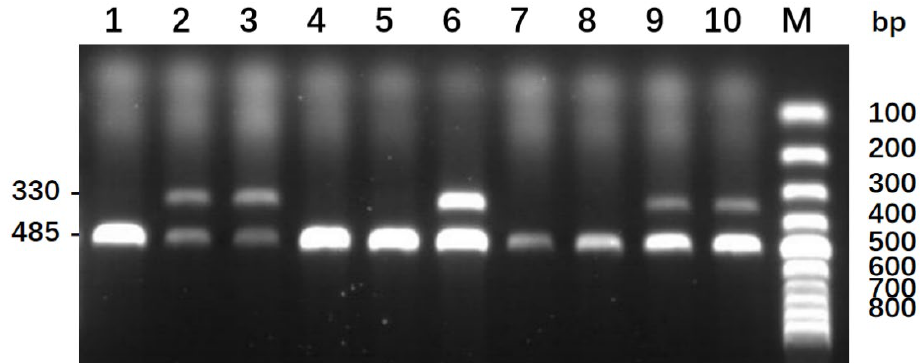
Figure 2. Sex identification results of micro whole blood PCR. Note: double bands are female geese (330 bp and 485 bp) and single bands are male geese (485 bp).